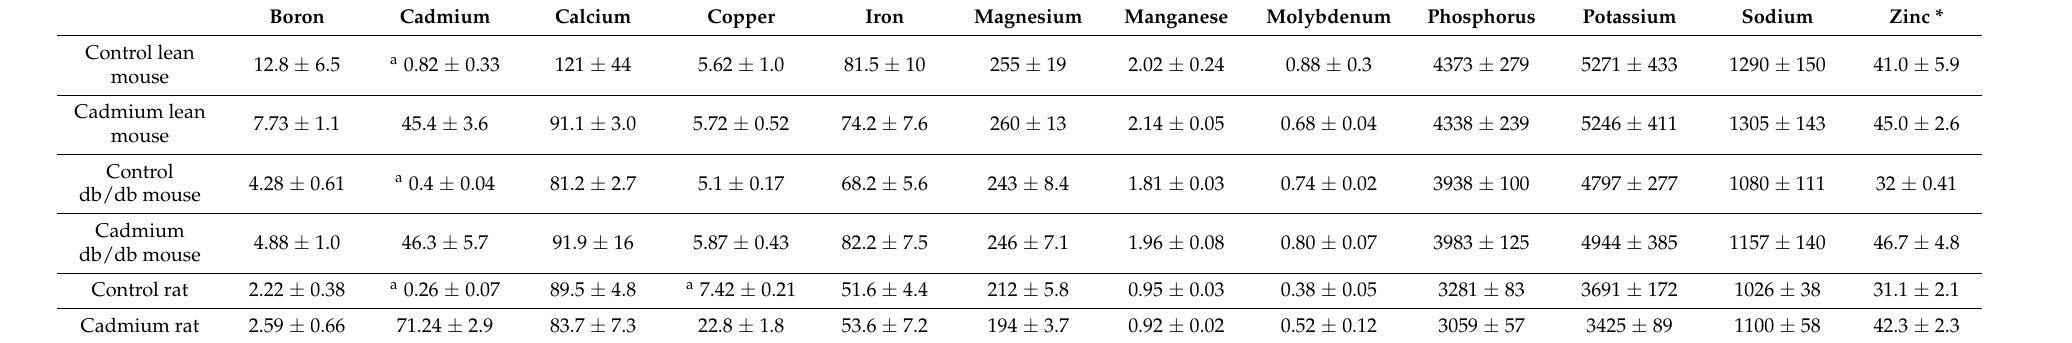
Table 1. Levels of metals in renal cortex ( µ g/g wet weight) after 2 weeks of 0.6 mg/kg/b.w./day of Cd dosing and 2 subsequent weeks of no Cd dosing; control animals received equal volume vehicle (saline) injections. Asterisk (*) indicate significant differences between control vs. cadmium treatment groups for whole data set; a = significant differences compared to Cd treatment within the same species/strain. All data are expressed as mean ± standard error µ g/g wet weight. Two-way ANOVA with Tukey’s multiple comparison post-tests test; p ≤ 0.05; n = 4 per group for mice and n = 6 for rats per